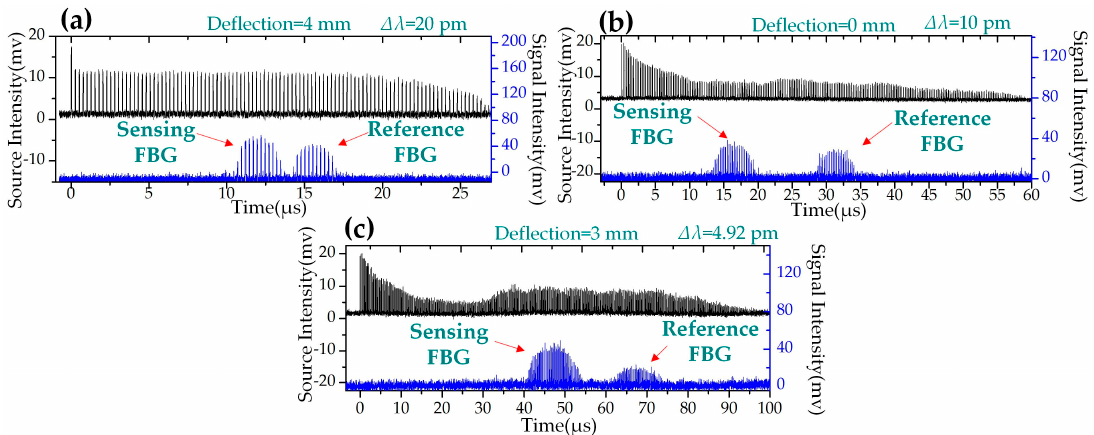
Figure 7. Waveforms of FBG strain sensing based on the WSSL with different sweep steps ( ∆ λ ). ( a ) ∆ λ = 20 pm and the deflection is 4 mm. ( b ) ∆ λ = 10 pm and the deflection is 0 mm. ( c ) ∆ λ = 4.92 pm and the deflection is 3 mm.